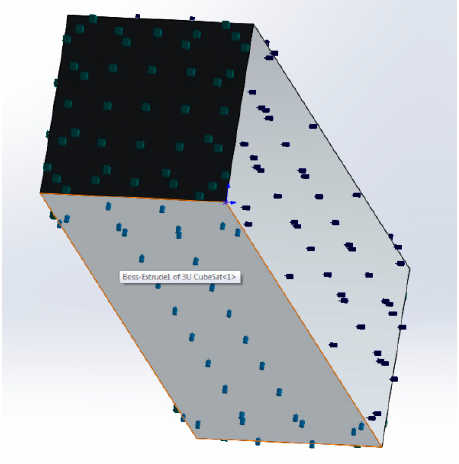
Figure 52. Applied Albedo and Earths Infra-Red Fluxes.